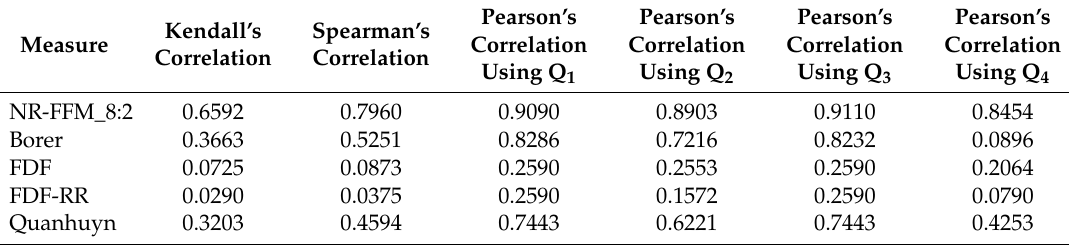
NR-FFM, was in Table 12 equal to that in Table 1, training-test ratio 8:2, mean value. In Table 13, NR-FFM was calculated according to Equation (7) and using SI H (from Equations (1) and (2)) as spatial information values. Table 12. Kendall’s, Spearman’s, and Pearson’s correlation for the LIVE mobile dataset—40 degraded video sequences (best values are marked in bold). Borer: no reference objective measure, FDF: no